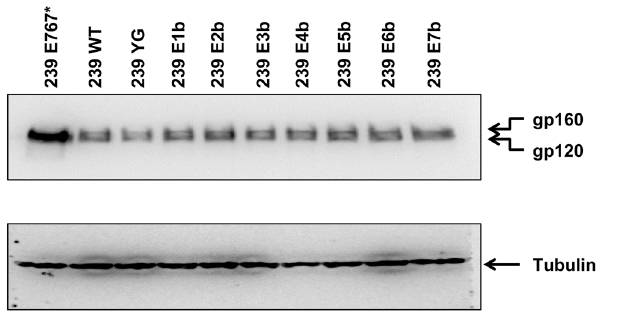
Figure 2. Point mutations of potential trafficking motifs do not affect cellular expression levels of SIVmac239 Env. HEK293Tcells were transfected with SIVmac239 Env mutants. On day 3 after transfection, cells were lysed and equivalent amounts of lysate analyzed by Western blot. gp120 and gp160 were detected by antibody 3.11H. Tubulin was used as input control. WT, wild-type; E767*, Env mutant with truncation at amino acid